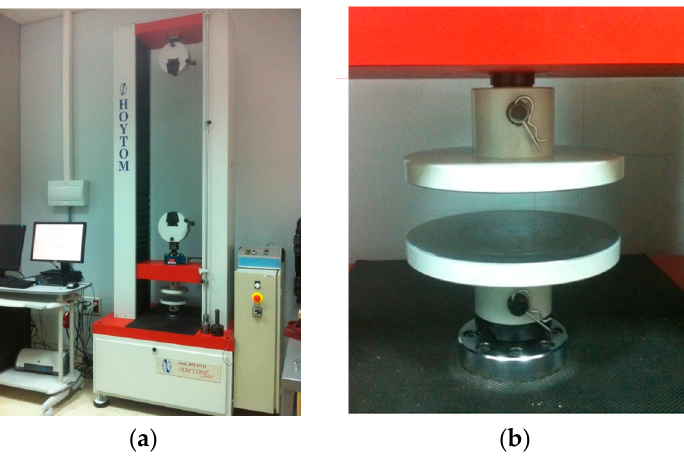
Figure 6. Equipment and forming tools. ( a ) Universal test machine HOYTOM HM-100kN; ( b ) Detailed view of flat platens.